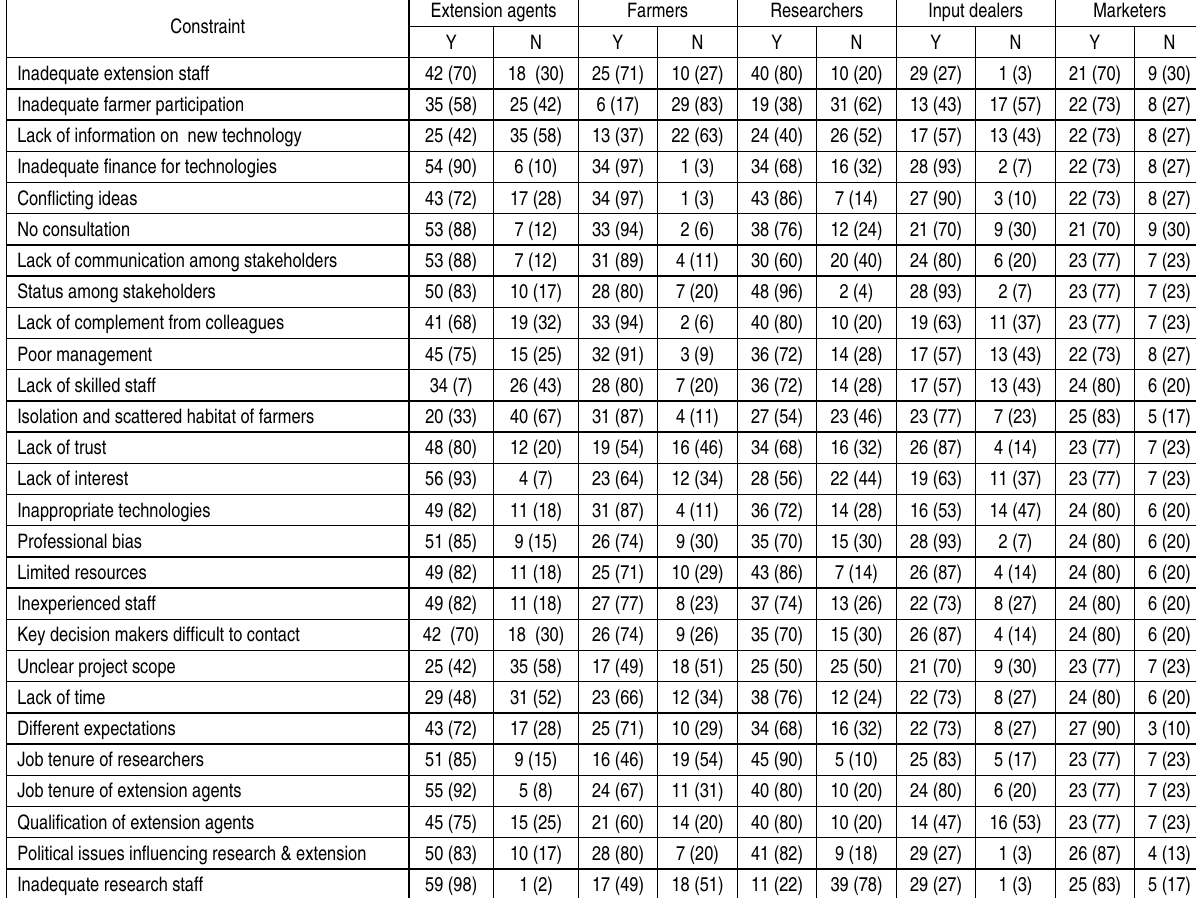
Table 2. Constraints to collaboration faced by extension agents, farmers, researchers, input dealers and